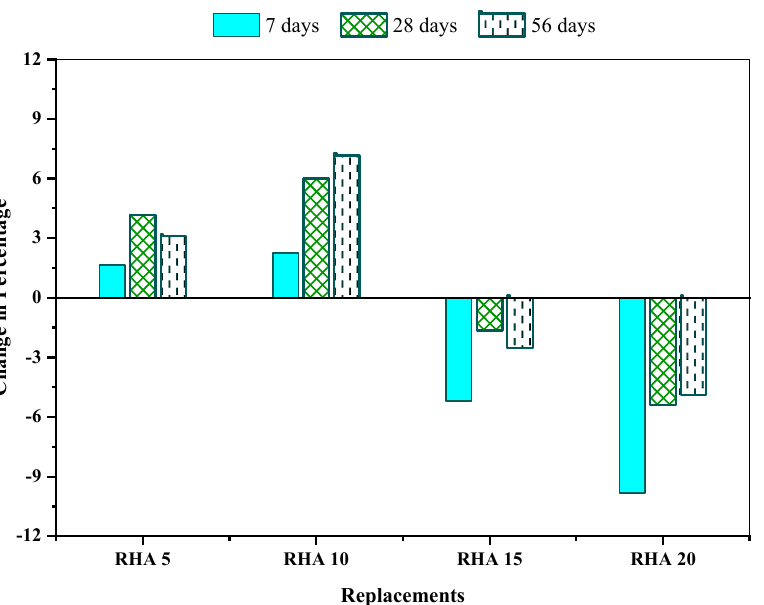
Figure 12. Flexural strength change (%) of the concrete mixes in comparison with the reference concrete.